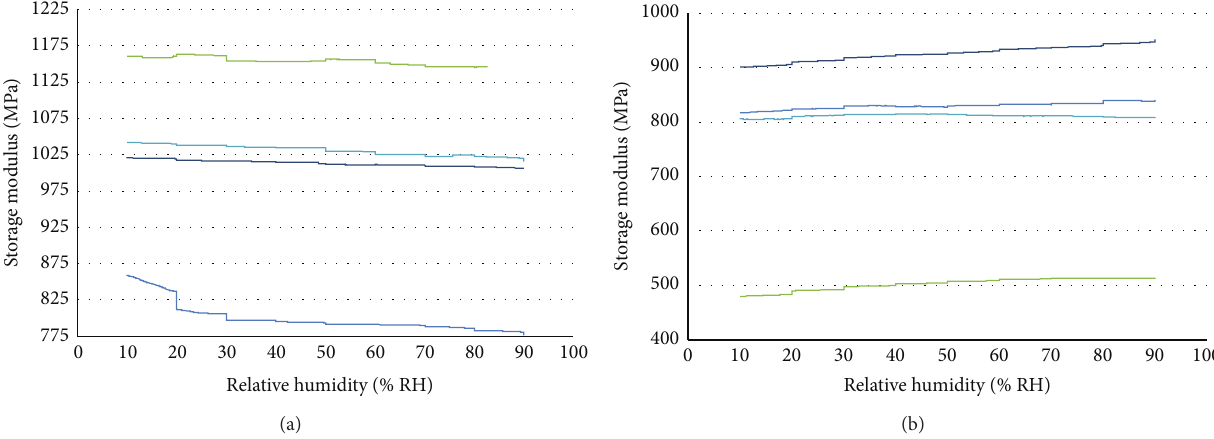
Figure 4: Variation of storage moduli versus humidity (DMTA analyses): (a) before aging and (b) after aging for (blue line) virgin PP, (green line) F20UT, (light blue line) F20AT, and (black line) F20AMAT.